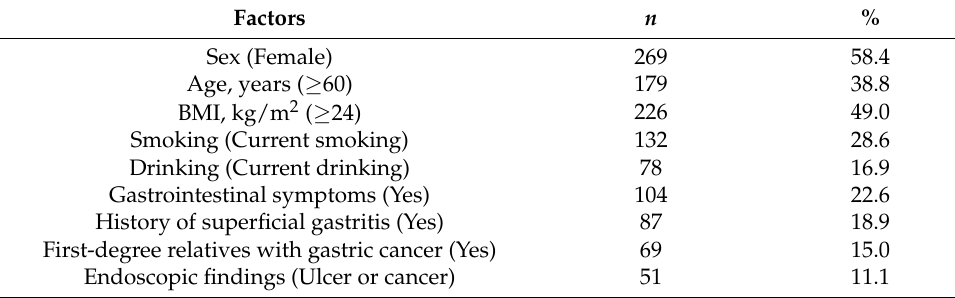
Table 2. The baseline information of H. pylori isolates (N = 461).